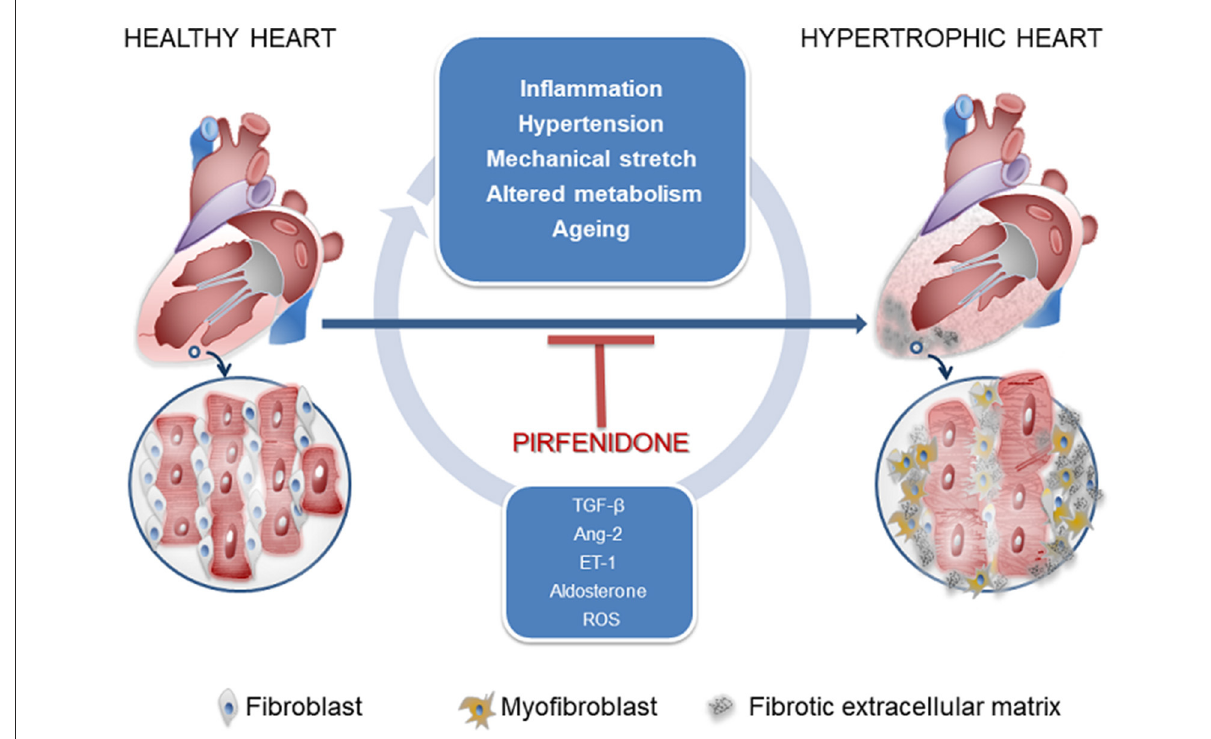
FIGURE1 Signals controlling fibroblast-to-myofibroblast transdifferentiation and favoring cardiac interstitial fibrosis.